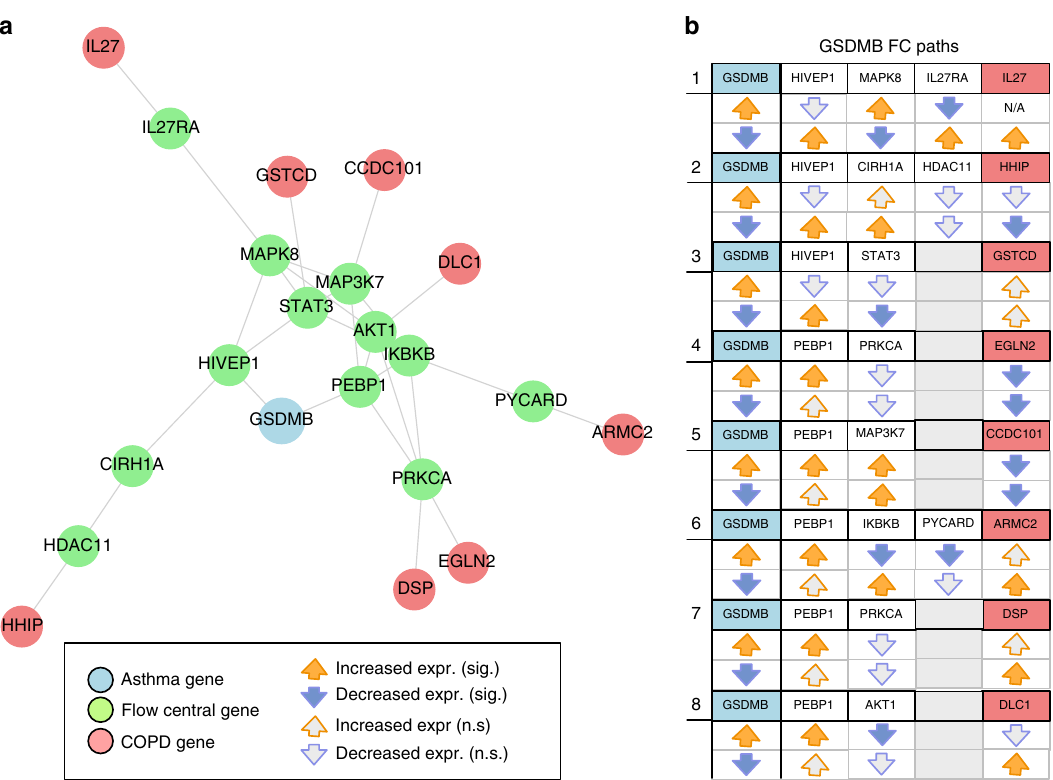
Fig. 6 Flow central paths between GSDMB and COPD seed genes. a Subnetwork of the nodes in the FC paths; b Set of eight fl ow central paths with GSDMB as source node and relative downstream changes in expression after overexpression/knockdown of GSDMB. For each column, the colored orange (blue) arrows represent signi fi cant overexpression (downregulation) of the corresponding gene, while gray arrows represent non-signi fi cant